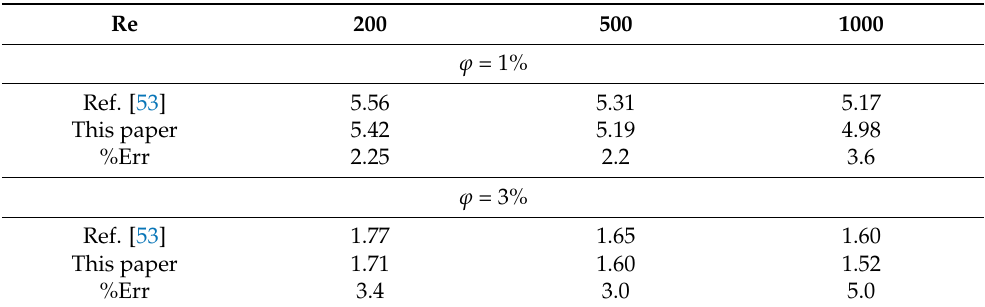
Table 4. The numerical model and Bizhaem and Abbassi [53] in the pressure drop at the Reynolds numbers of 200, 500, and 1000 for volume fractions of 1% and 3%.